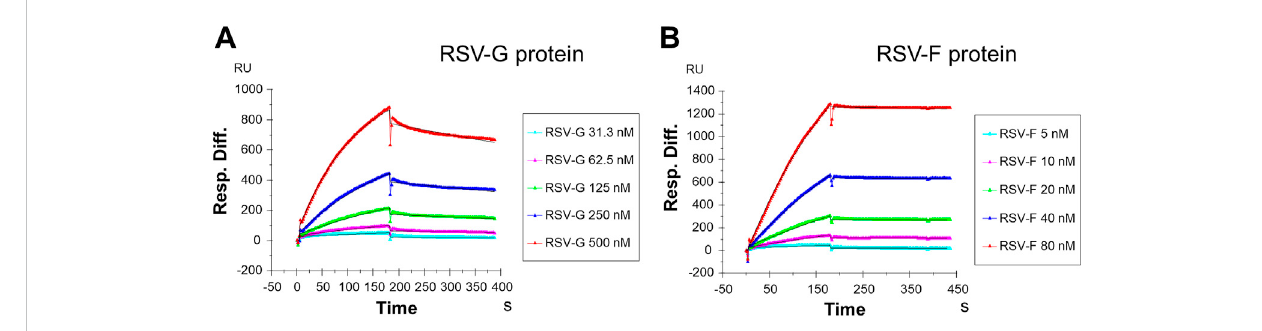
FIGURE 1 SPR sensorgrams of RSV-G protein and RSV-F protein binding with heparin. (A) SPR sensorgrams of RSV-G protein binding with heparin. Concentrations of RSV-G protein (from top to bottom) are 500, 250, 125, 62.5 and 31.3 nM, respectively. (B) SPR sensorgrams of RSV-F protein binding with heparin. Concentrations of RSV-F protein (from top to bottom) are 80, 40, 20, 10, and 5 nM,